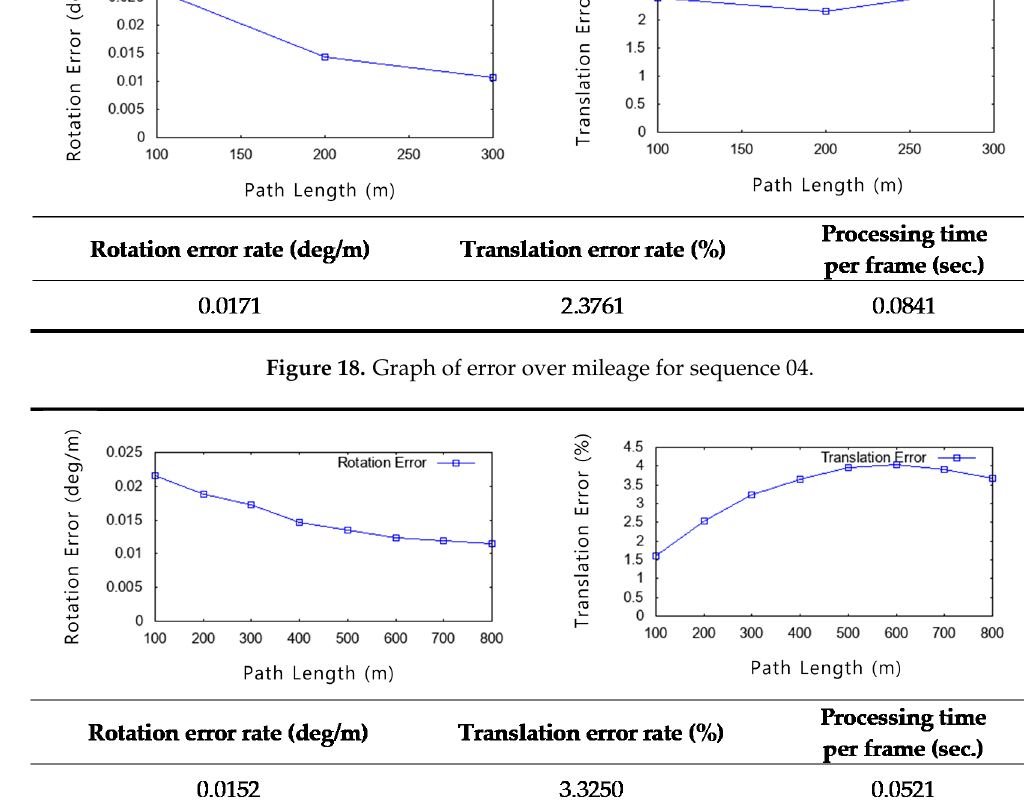
Figure 19. Graph of error over mileage for sequence 05.